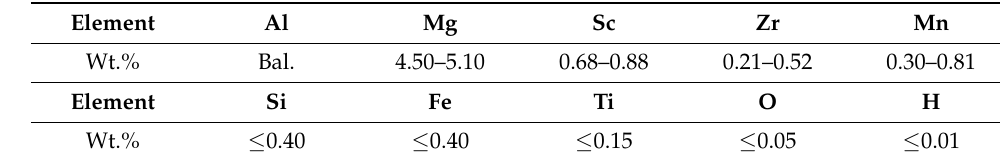
Table 2. Al–Mg–Sc–Zr powder composition.